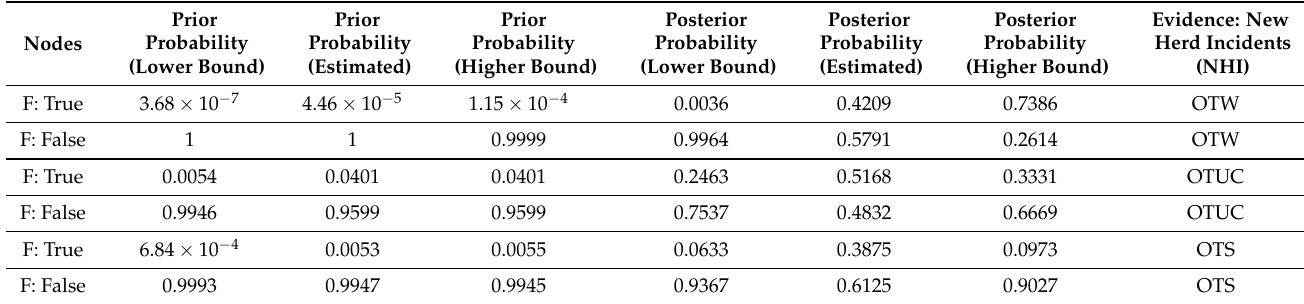
Table 9. Prior and posterior probabilities for node F in high-risk areas of England cattle farms. Nodes